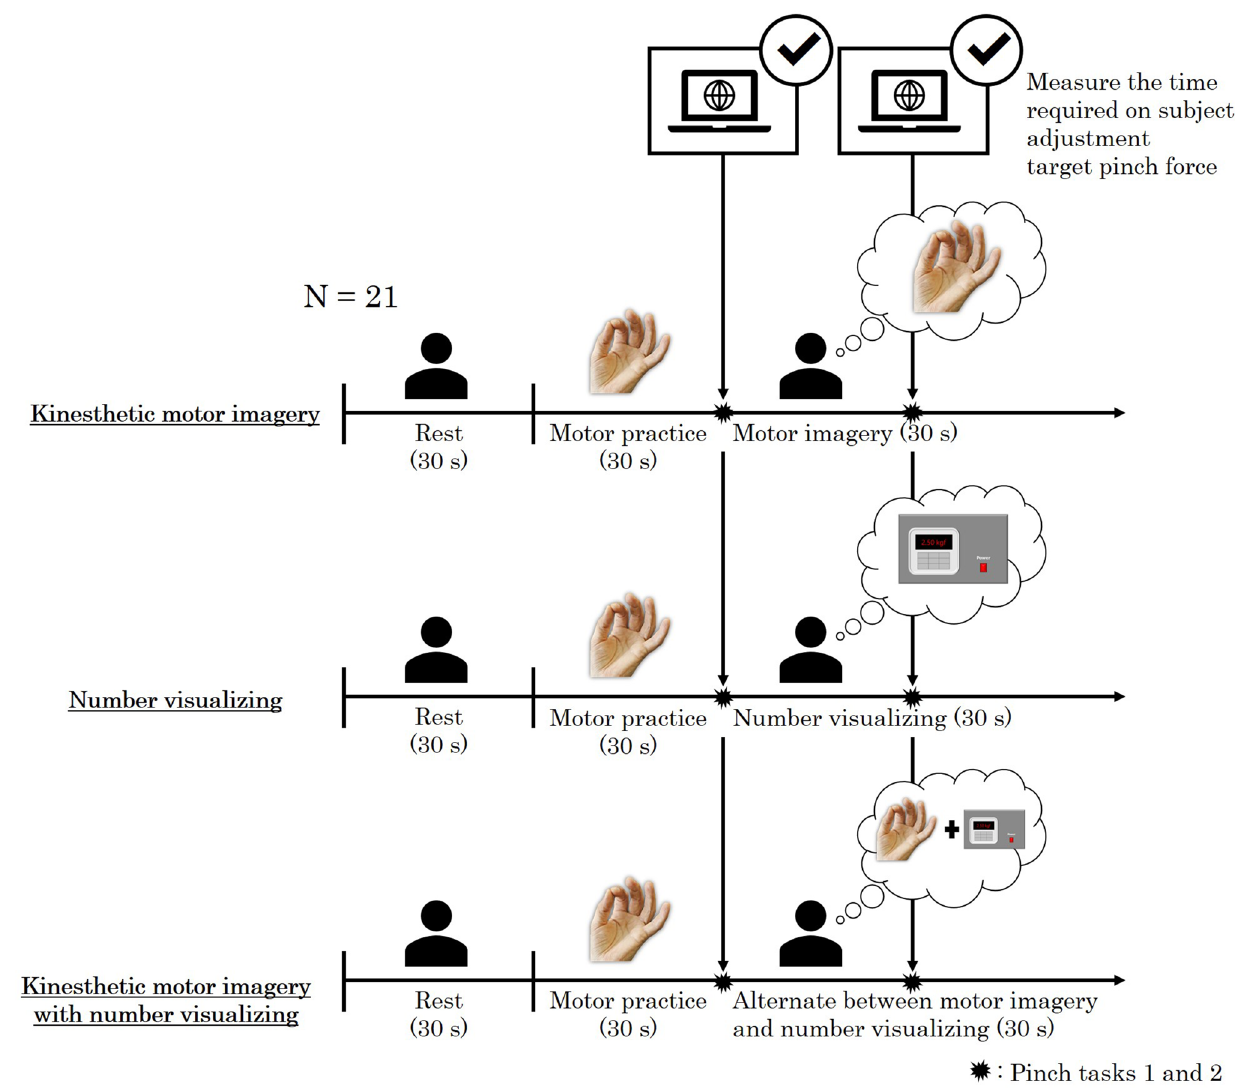
Figure 3. Study procedure. We examined the F-waves of the left thenar muscles after stimulating the left median nerve at the wrist at rest and during MI trials performed in a random order. The KMI condition consisted of imagining performing muscle contractions; the number visualizing condition consisted of imagining the pinch force increasing numerically; and KMI with number visualizing condition consisted of alternating between KMI and number visualization. Before and after MI, the ability of the participants to quickly adjust to the target pinch force was evaluated, and the time required to adjust to the target was compared between the